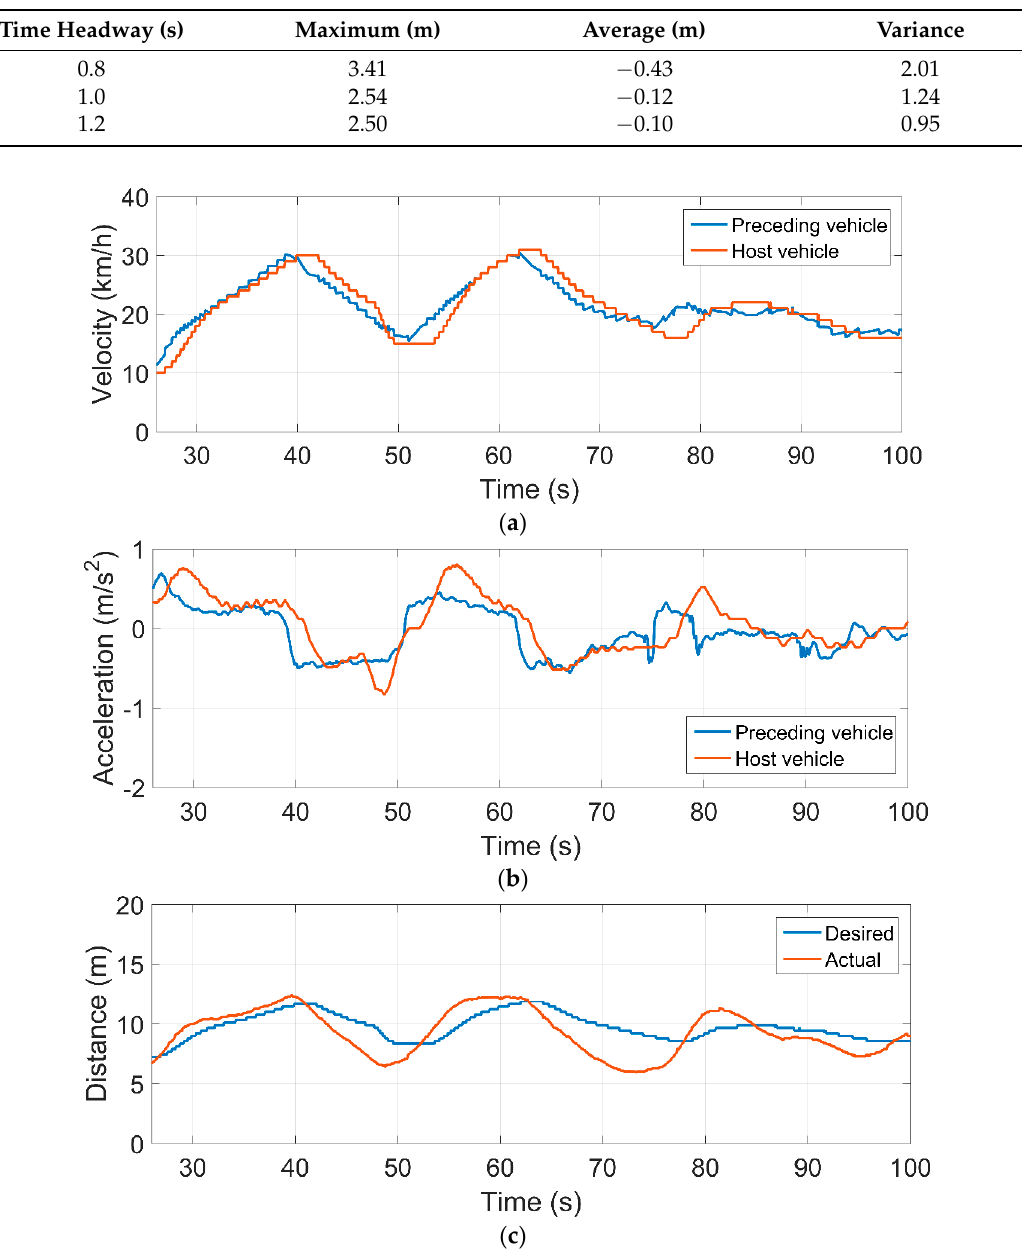
Figure 10. Test results with an 0.8-s time headway: ( a ) velocity, ( b ) acceleration, and ( c ) distance.